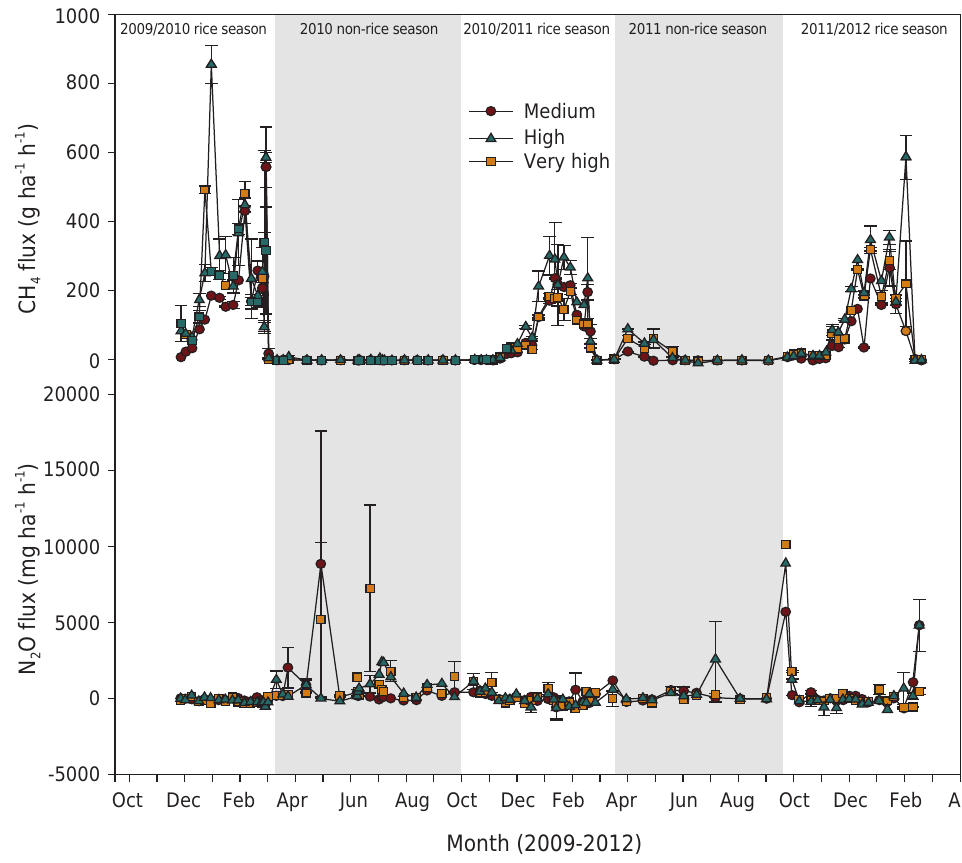
Figure 2. Methane and N 2 O fluxes from rice paddy soil over three cropping seasons (unshaded bands) and two non-rice seasons (shaded bands) under medium, high, and very high crop management levels in southern Brazil. Vertical bars represent standard